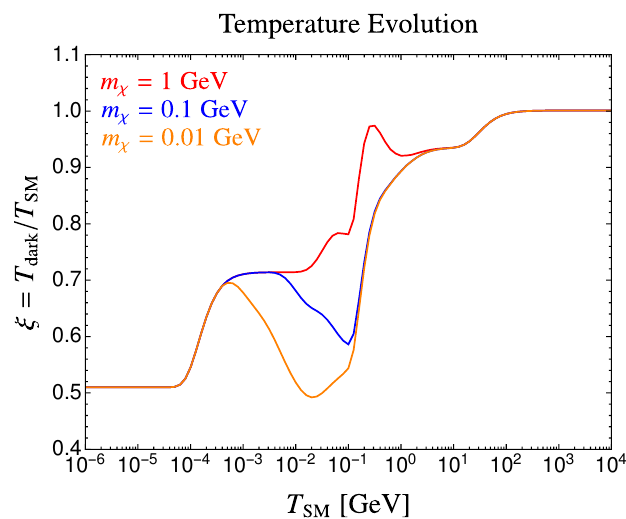
Figure 10 . Dark sector temperature evolution as a function of the SM photon temperature in the decoupled dark sector model of section 3.2. We have assumed that the two sectors begin at the same temperature, (cid:24) R = 1, above the weak scale. For each m (cid:31) , (cid:1) is (cid:12)xed to reproduce the observed relic density. The remaining parameters are set to m (cid:30) = m (cid:31) = 4, y = e i(cid:25)= 4 , and (cid:14) = 10 (cid:0) 4 e i(cid:25)= 4